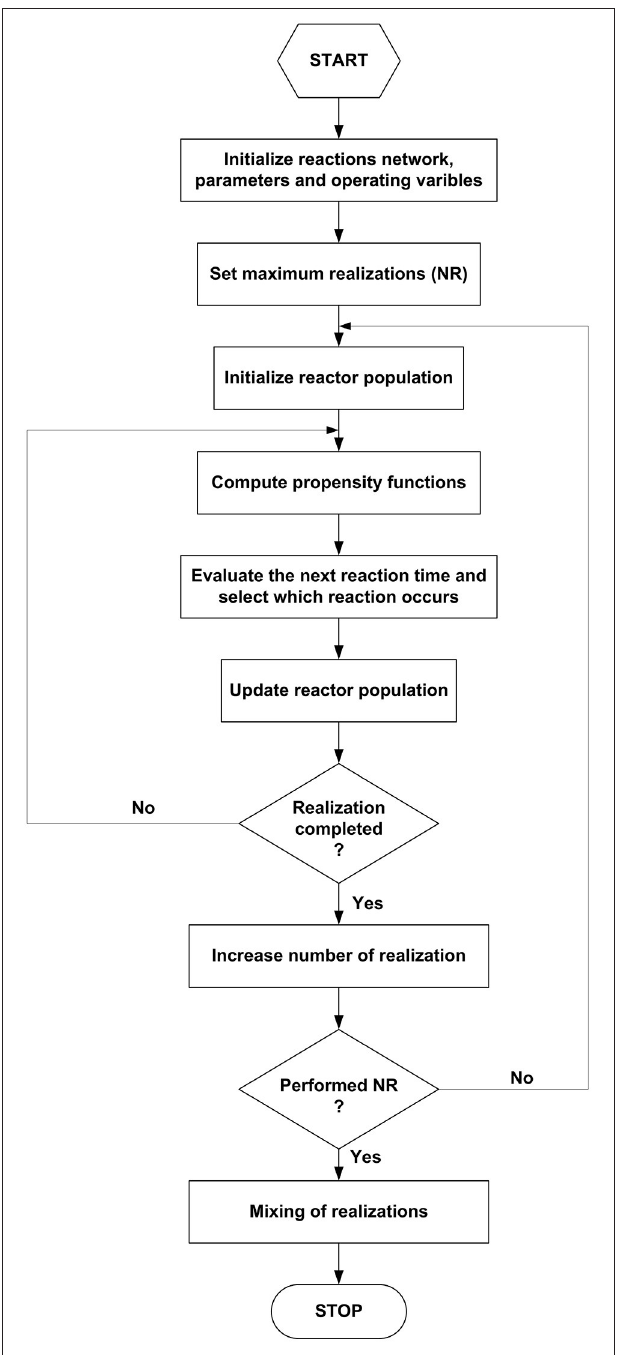
FIGURE 3 | Schematic flowchart of program (B). See the text for